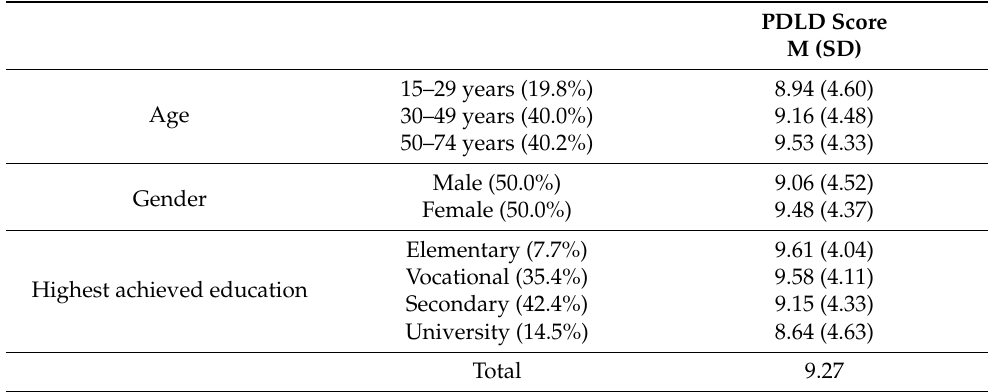
Table 3. PDLD scores within the selected subpopulations.